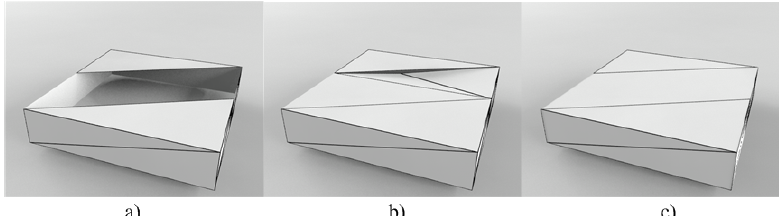
Figure 8. Demonstration of the effect of Constraint IV (a) a cube with a hole; b) the result of repair without the constraint IV; c) the result of repair with the constraint IV)